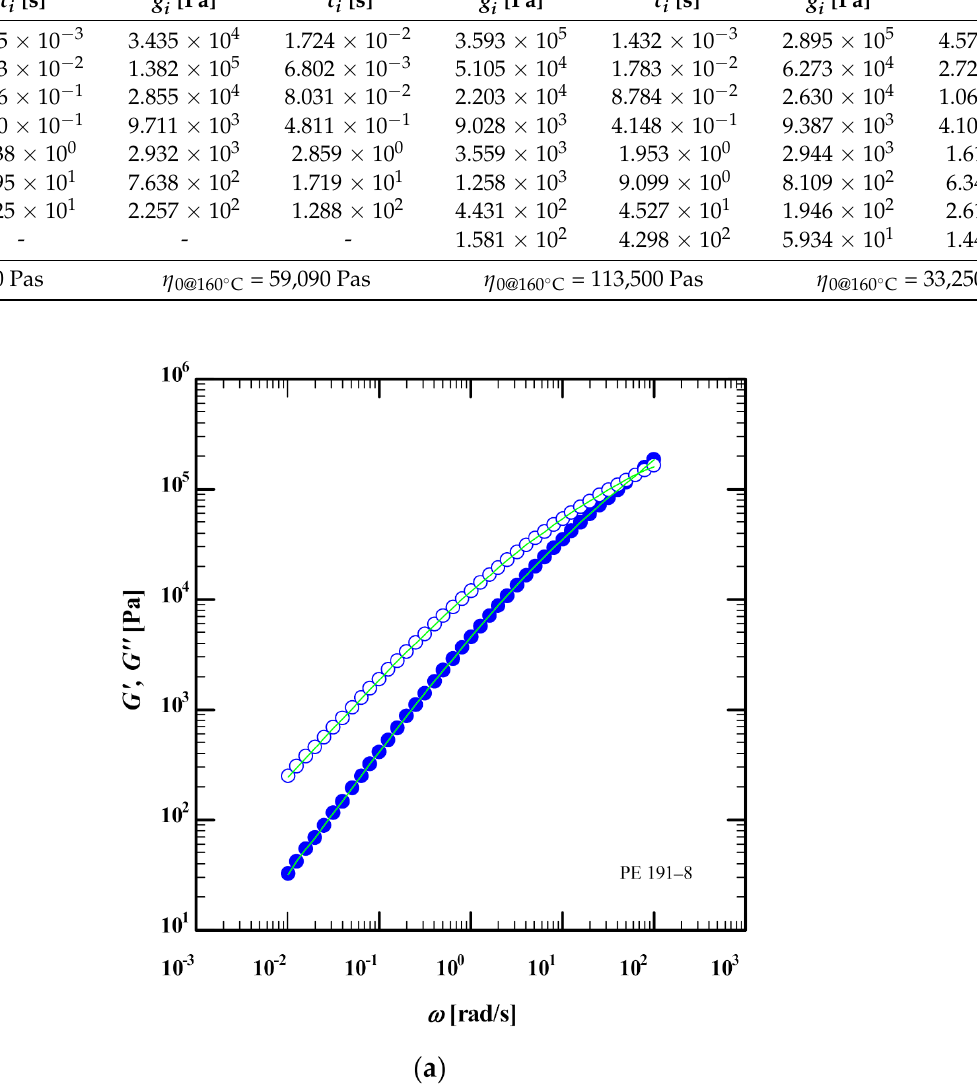
Table 1. Discrete relaxation spectrum and zero-shear viscosity of PE 191-8, PE 127-9, PE 124-10 and PE 236-12 (at T = 160 ◦ C) by us using the IRIS software (green lines), and by Morelly and Alvarez [23], respectively. PE 191-8 (IRIS).